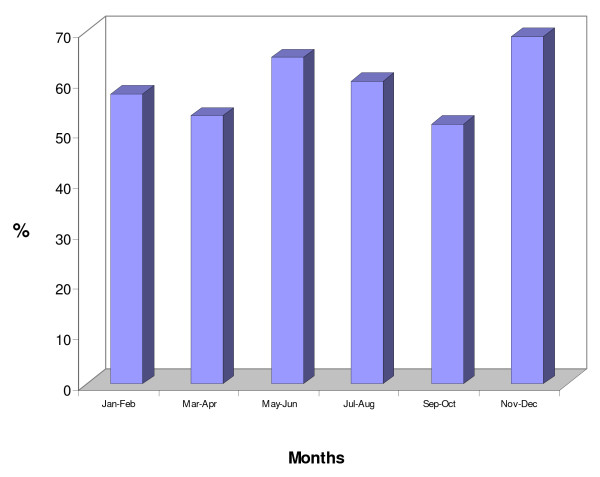
Haemoglobin concentrations by survey round: % with Hb concentration less than 11 g/dL.